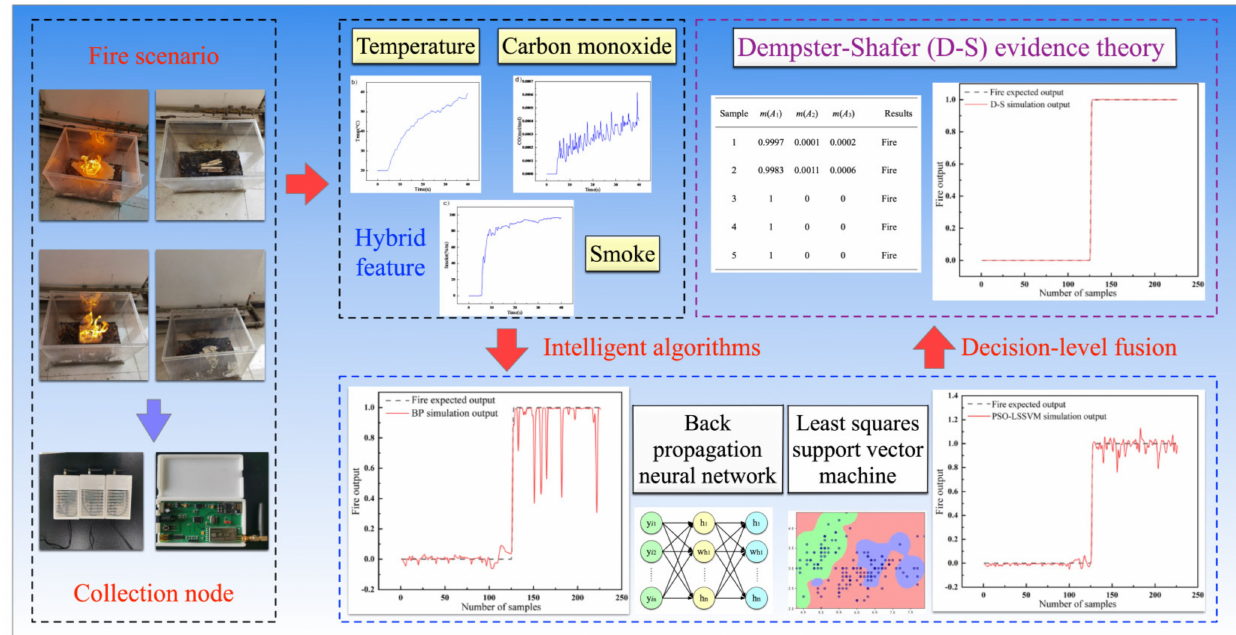
Figure 1. Overall design of the early fire detection and warning